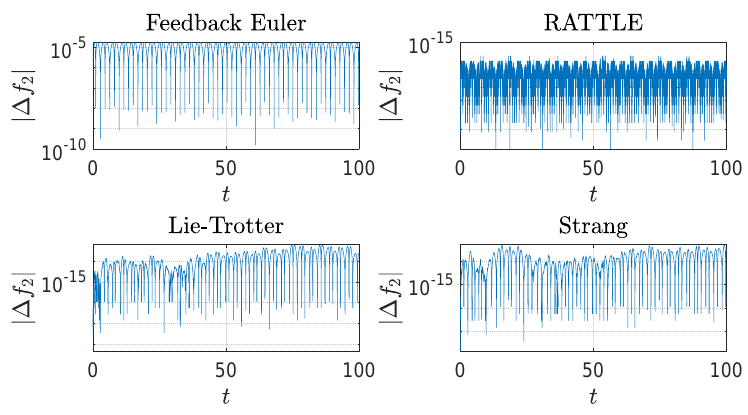
Figure 2. The trajectories of the deviation, | ∆ f 1 ( t ) | = | f 1 ( t ) − f 1 ( 0 ) | , 0 ≤ t ≤ 100, of the spherical pendulum from the constraint set, (cid:107) q (cid:107) 2 = 1, generated by four different methods with step size h = 10 − 3 : a feedback integrator with the Euler scheme, the RATTLE method, the Lie–Trotter splitting method, and the Strang splitting method. A logarithmic scale is used on the y -axis.